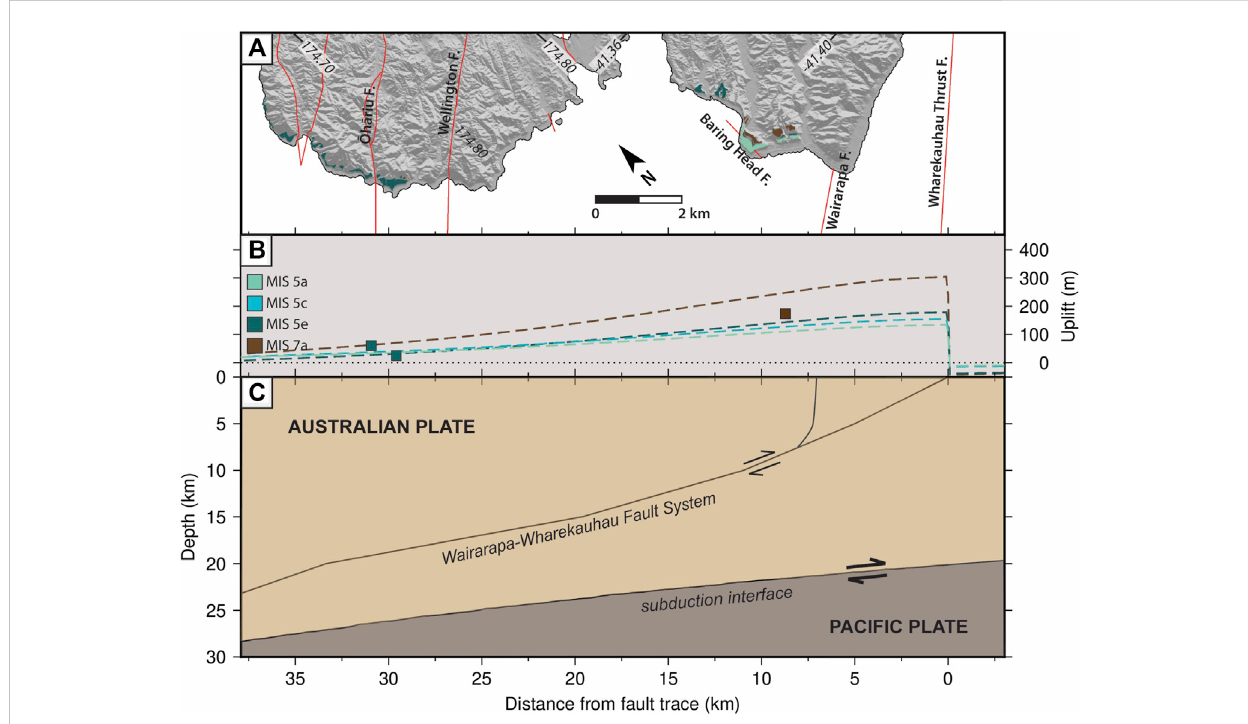
FIGURE 8 Dislocationmodellingresultsofupliftfrom2 mm/yrsliponalistricWairarapa-Wharekauhaufaultsystem — selectedtomimicthegeometryinferred byHenrysetal.(2013)furthernorth — andassumingaT e of40 km.Themodelledfaultsystemdips45 ° Wbetweenthesurfaceand5 kmverticaldepth;40 ° between5and10 kmdepth;30 ° from10to15 kmdepth;and20 ° to20 kmdepth.Thefaultthensteepens,dippingat35 ° Wto30 kmdepth. (A) Hillshaded topography,majoronshoreandoffshorefaultzonesandmappedmarineterracetreads(colouredbyterraceage)intheareaofourmodelledpro fi le. (B) Modelled and observed uplift along the pro fi le. Dashed lines show modelled uplift and coloured squares show observed uplift; both modelled and observed uplift arecolour-codedby age. (C) Modelledfault geometryand depth to theHikurangi Subductioninterface along ourpro fi le. Note2x vertical